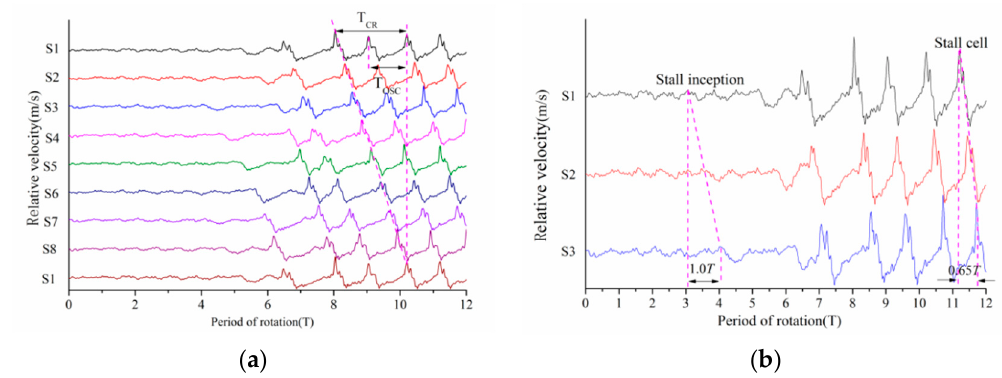
Figure 14. Relative velocity curve of the monitoring point when the flowrate is 1.0 kg/s: ( a ) the curve of the relative velocity at 8 points; ( b ) the curve of the relative velocity at 3 adjacent points.